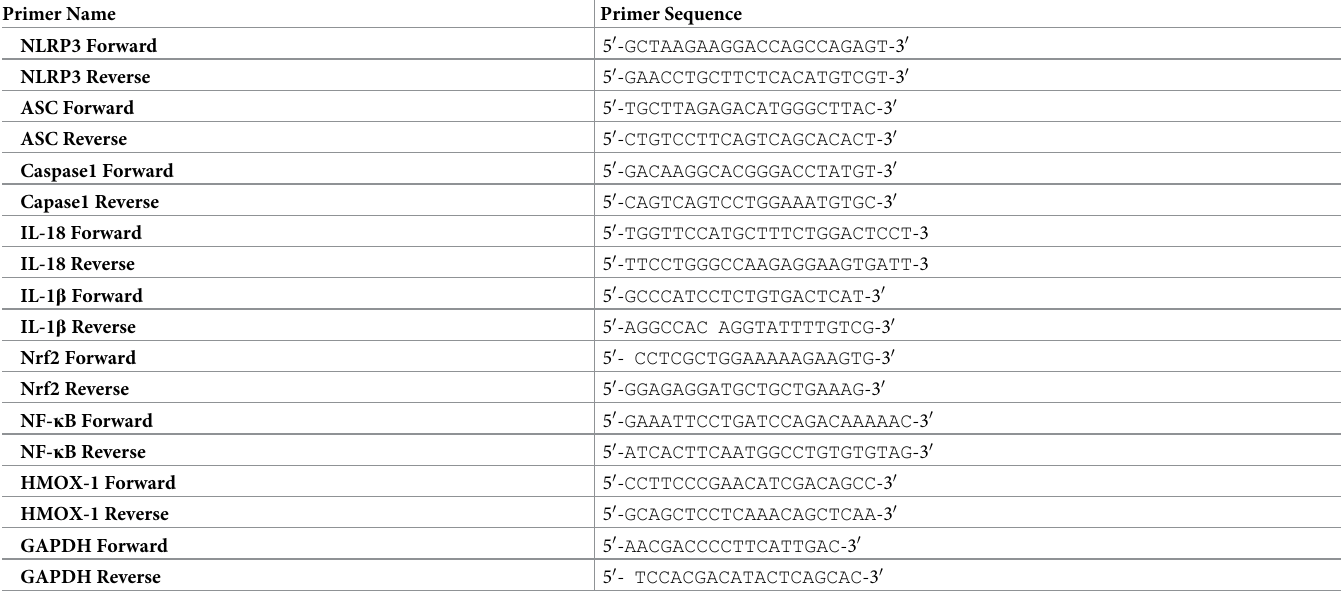
Table 1. Primers sequence for the investigated